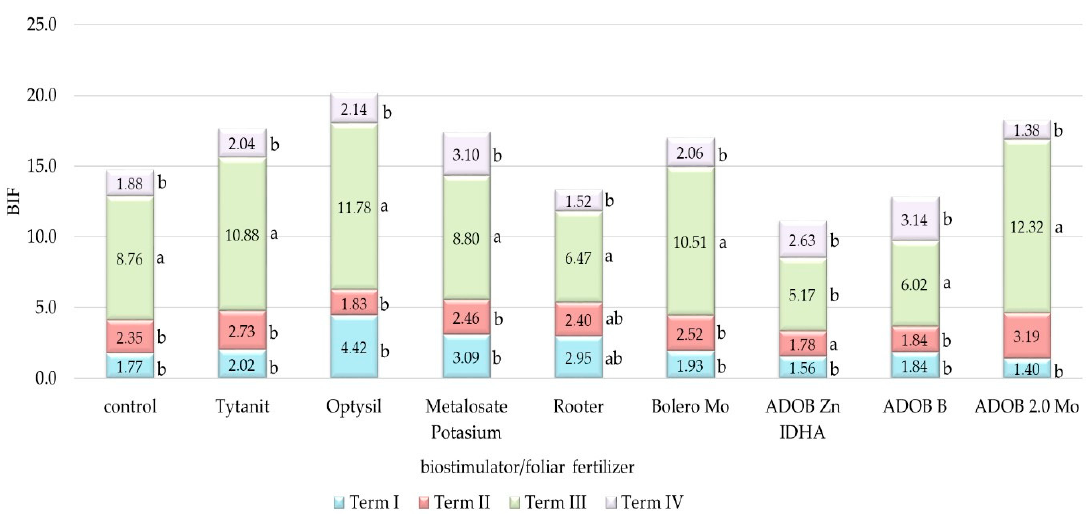
Figure 8. The influence of the bio-stimulants and fertilizers on the BIF. Abbreviation: a, b—homogenous groups according to Duncan’s test at level p = 0.05; I term—at the plants’ emergence (BBCH 5–10), II term—at the plants’ full growth (BBCH 35–40), III term—at the at the plants’ florescence (BBCH 51–59), IV term—after harvest.